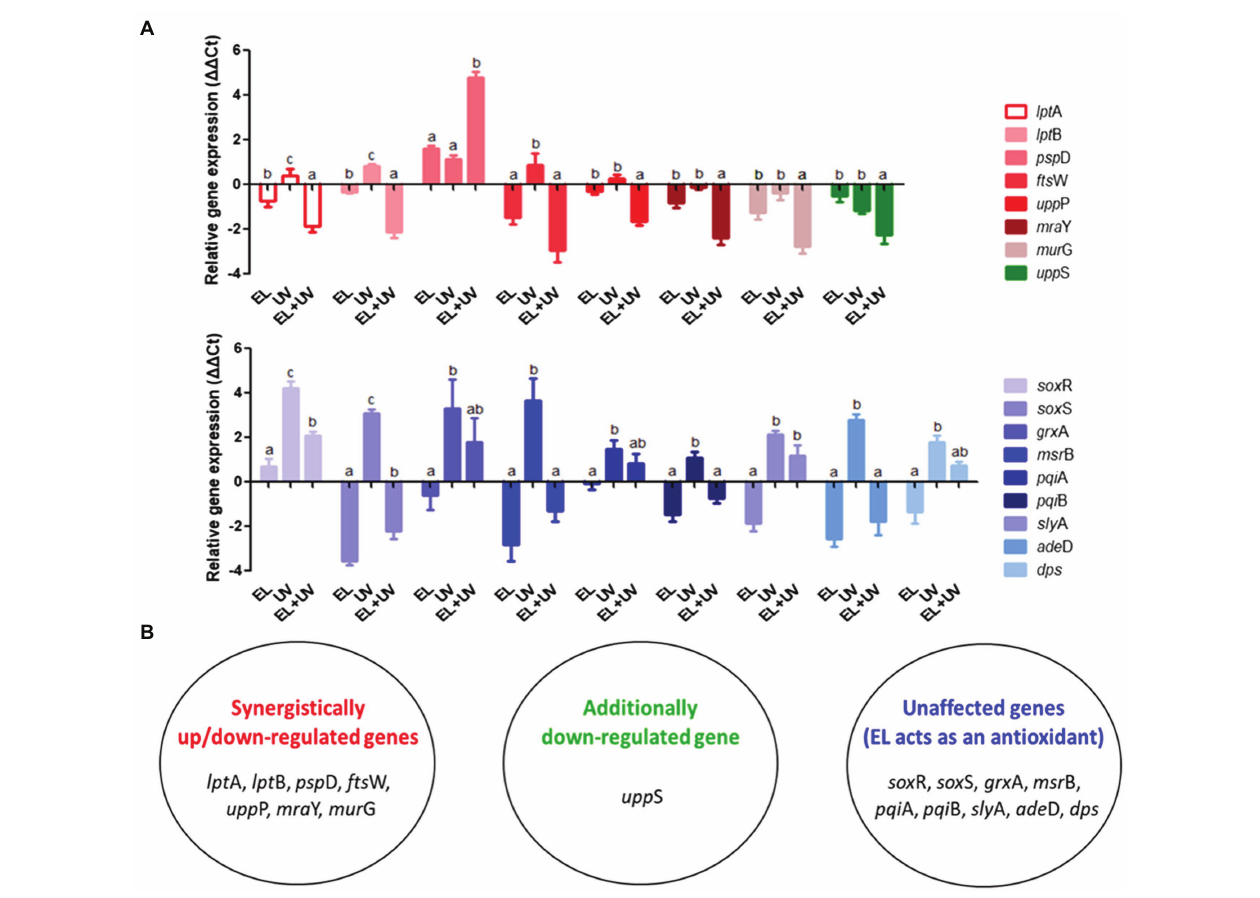
FIGURE 5 | (A) Expression levels of genes related to membrane synthesis/stress and oxidative stress responses in E. coli MG1655 cells determined by reverse transcription-quantitative PCR (RT-qPCR). Bacterial cells were non-adapted (control) or adapted to sublethal EL concentrations (1 mM), UVA light (UV, 15 min), or EL/UVA co-treatment (EL + UV, 1 mM EL, and 15 min UV treatment). (B) Grouping of the synergistically affected, additively affected, or unaffected genes. The mean values from three independent measurements are shown. Different lowercase letters indicate significant differences ( p ≤